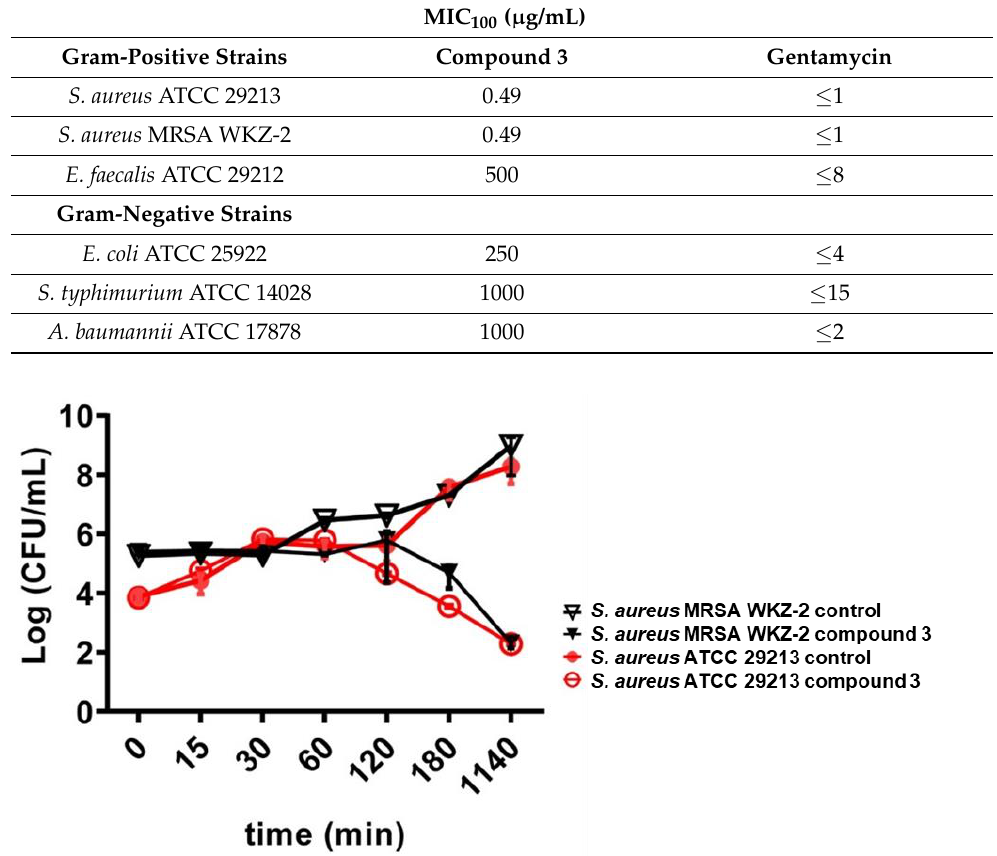
Figure 4. Time-killing curves obtained by incubating S. aureus ATCC 29213 (red lines) and S. aureus MRSA WKZ-2 (black lines) with kaempferol-3- O - α - L - (2″ - E - p - coumaroyl,4″ - E - p -coumaroyl)-rhamnoside (compound 3 ) for different time intervals. Data represent the mean (±standard deviation, SD) of at least three independent experiments, each one carried out with triplicate determinations.